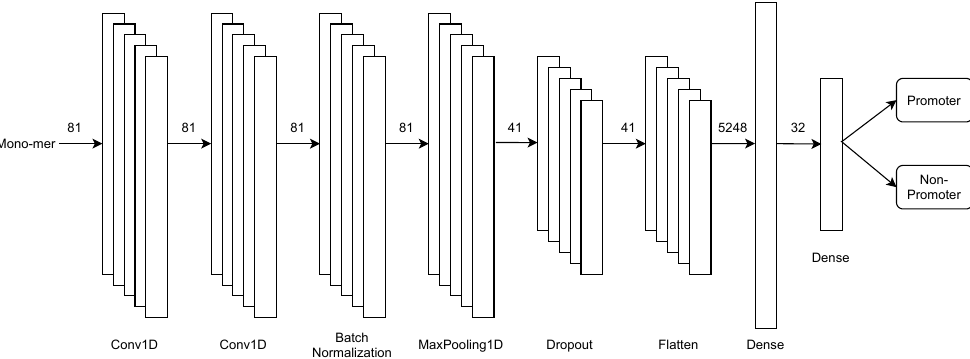
Figure 3. First-stage multiclass CNN architecture for promoters recognition in